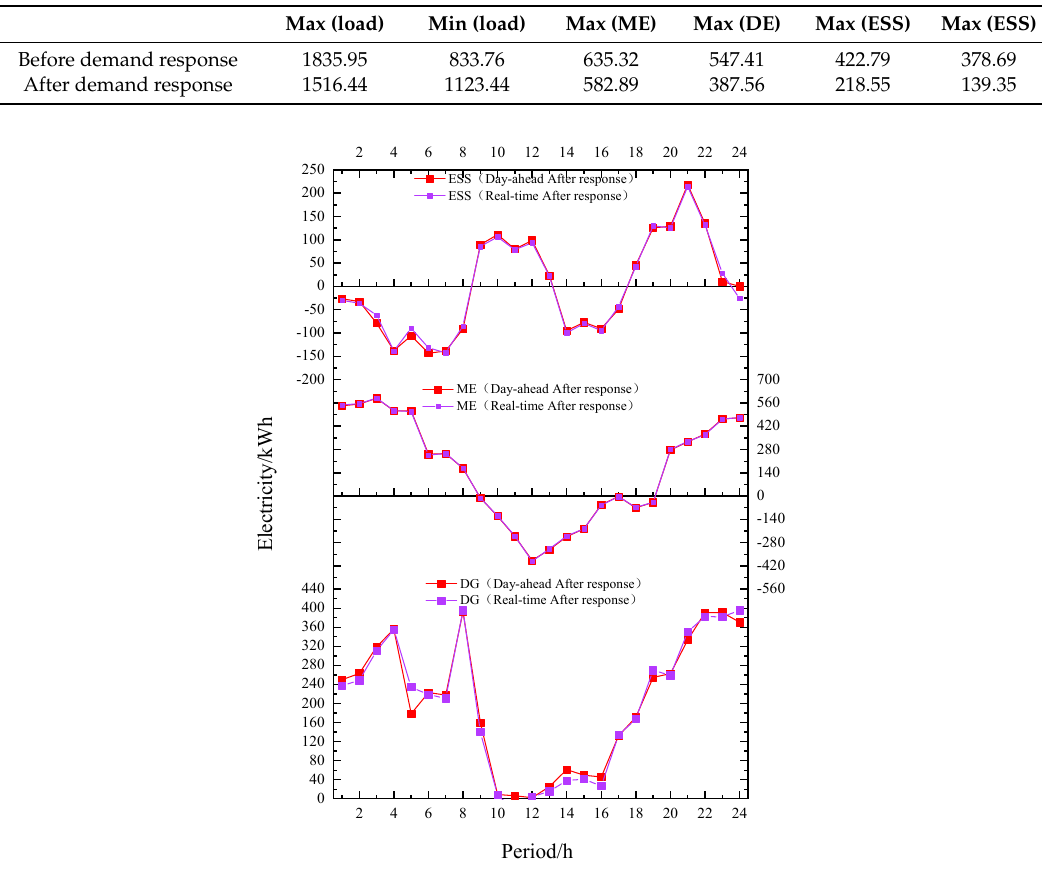
Figure 10. The comparison of the two-stage optimal scheduling results (demand side management).